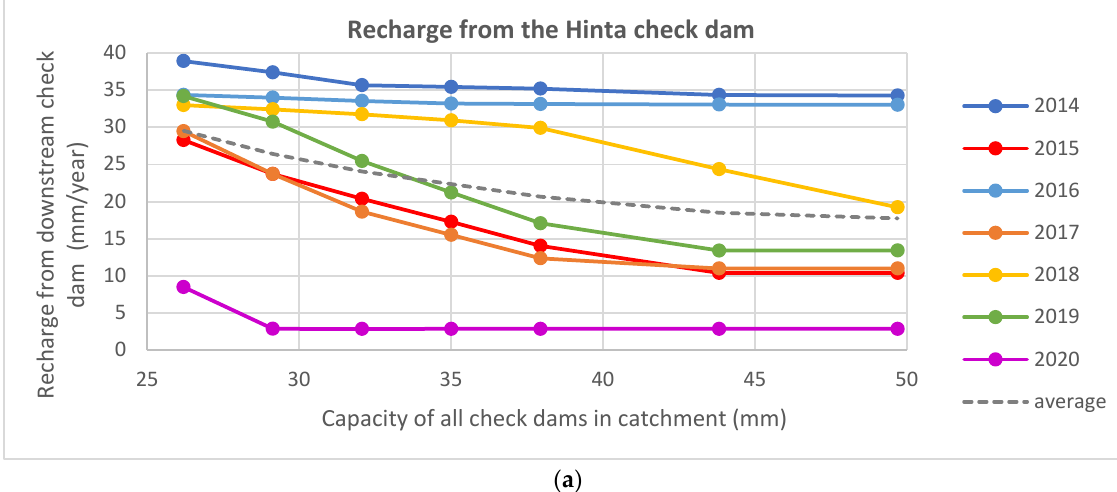
Figure 6. Predicted impact of hypothetical upstream check-dam development in the Dharta catch- ment: ( a ) the recharge from the downstream check dam; ( b ) the total recharge from all check dams; and ( c ) the spill from the downstream check. Note that the 2016 estimated spill of 372 mm (reducing to 354 mm) far exceeds other years and is excluded from ( c ). (No spill in 2015, 2017 or 2020.)